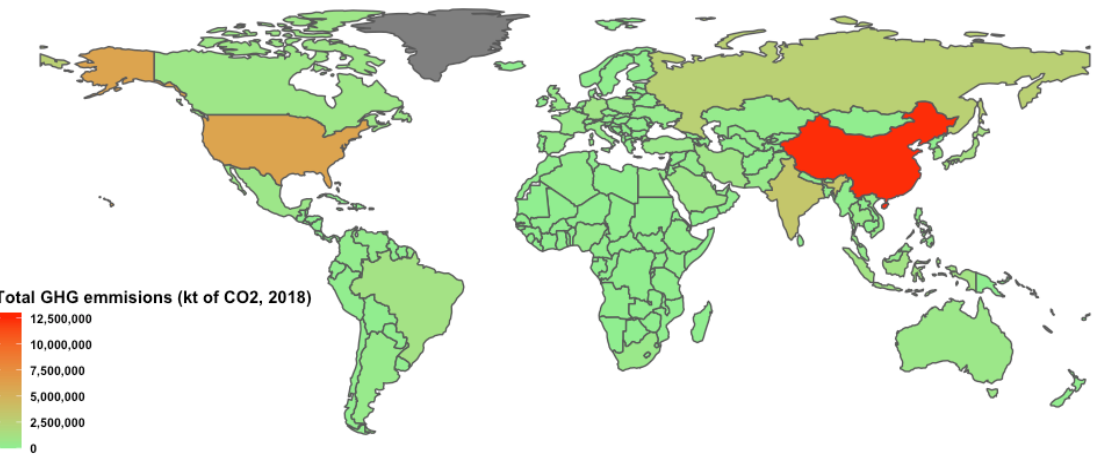
Figure 2. Worldwide GHG emissions in 2018. Authors’ representation. Source of data: World Development Indicators (WDI).